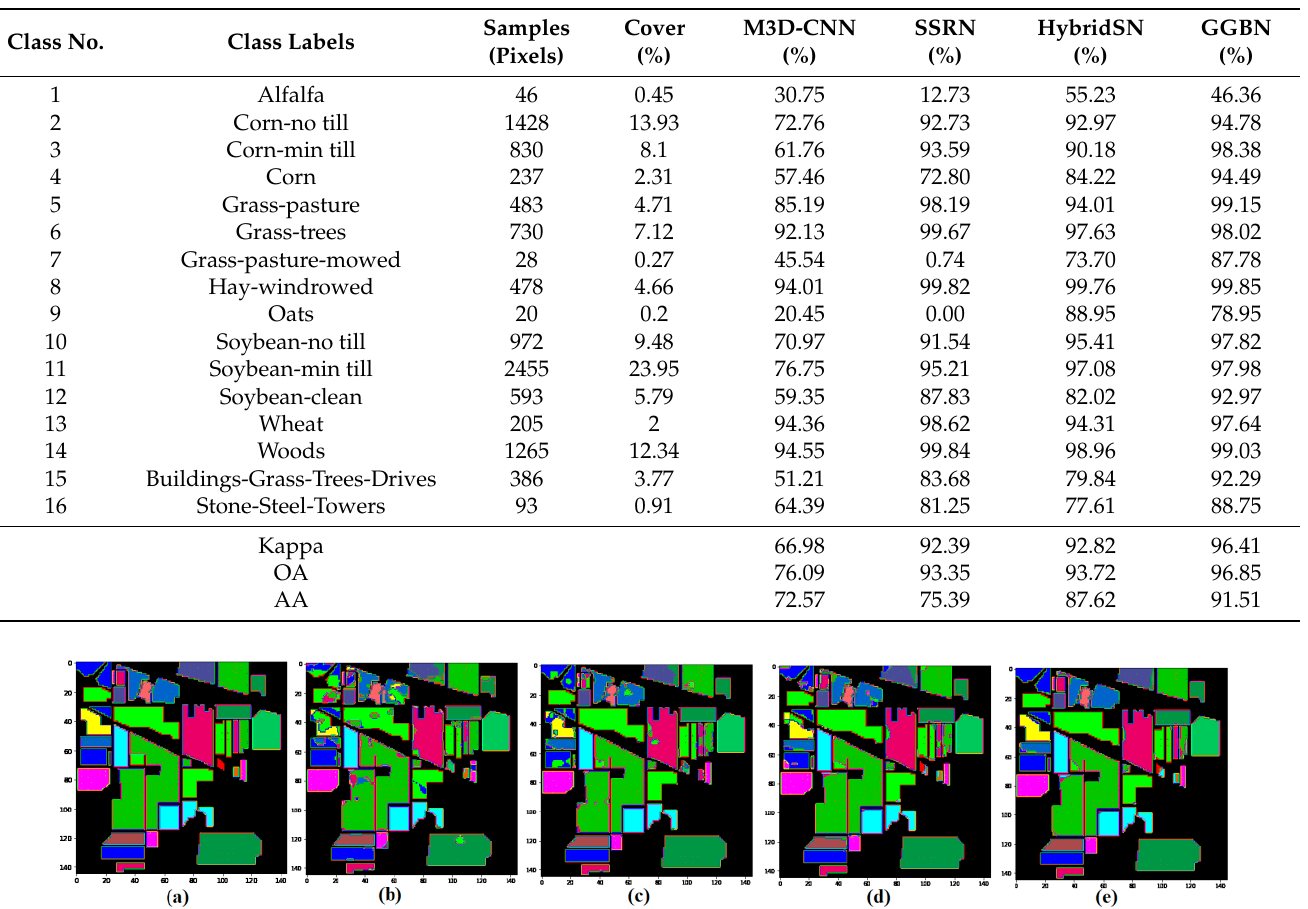
Table 2. Classification Results (%) over IP dataset.